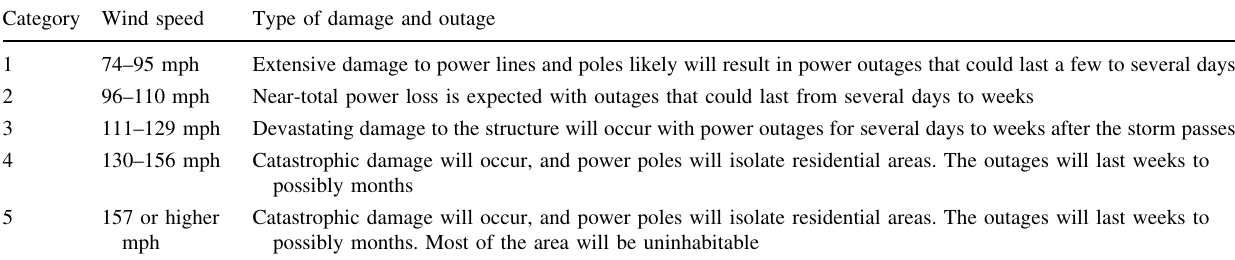
Table 1 Saffir-Simpson hurricane wind scale. Source NOAA (2019a) Category Wind speed